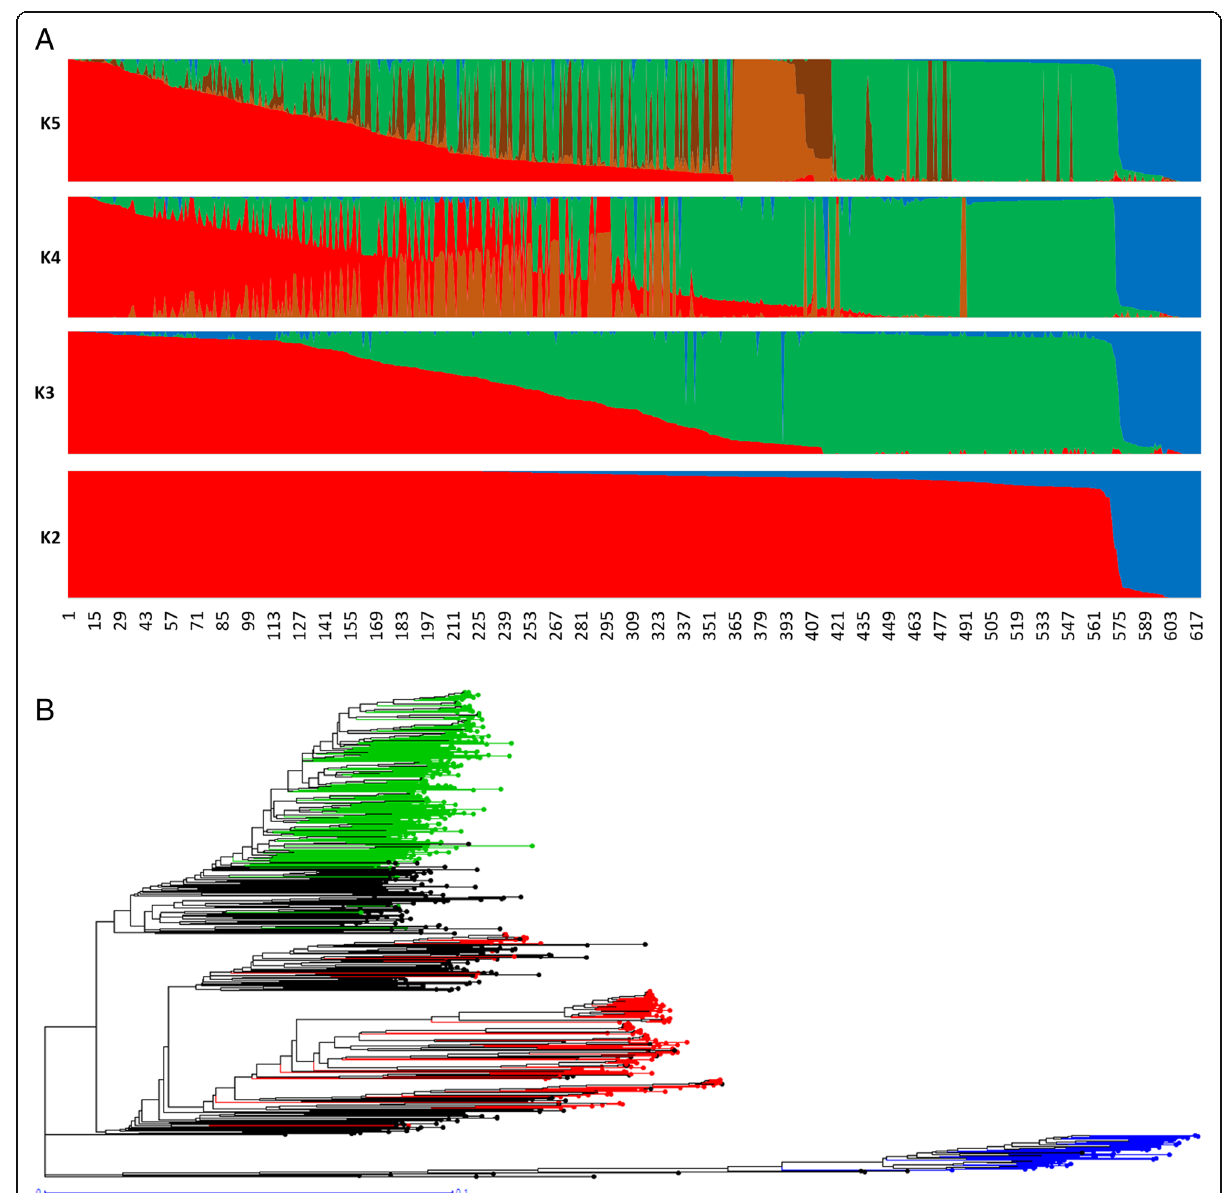
Fig. 2 Population structure in 620 Malagasy rice accessions estimated from 32,614 SNPs. a : Output of sNMF for K = 2 to K = 5; b : Unweighted neighbour-joining tree of simple matching distances. Tree branches are coloured according to membership of sNMF groups at K = 3 and ancestry coefficient threshold of